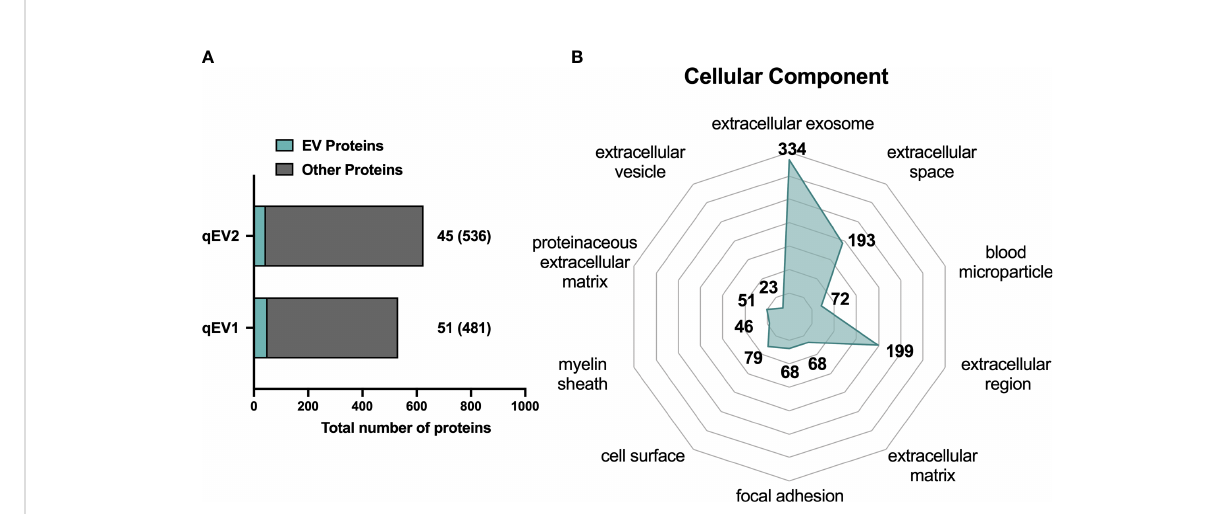
FIGURE 3 Proteomic analysis of NOD mouse plasma EVs isolated by qEV. Plasma was collected from non-diabetic NOD mice and EVs were enriched using qEV (pooled fractions 7-10). LC-MS/MS analysis was performed with EVs enriched from 800 m L of pooled plasma from two pre-diabetic NOD mice. The two technical replicates were analyzed and are presented as qEV1 and qEV2. (A) Bars indicate the total number of proteins identi fi ed in the technical replicates. Of these the number of proteins found in the Vesiclepedia top 100 EV protein list are depicted in green. Numbers given in brackets indicate the proteins that are not listed among the top 100 EV proteins. (B) The top 10 enriched GO terms for cellular components after GO analysis of all identi fi ed proteins. The numbers represent the unique proteins in each term and the enriched GO terms were scored according to a p -value